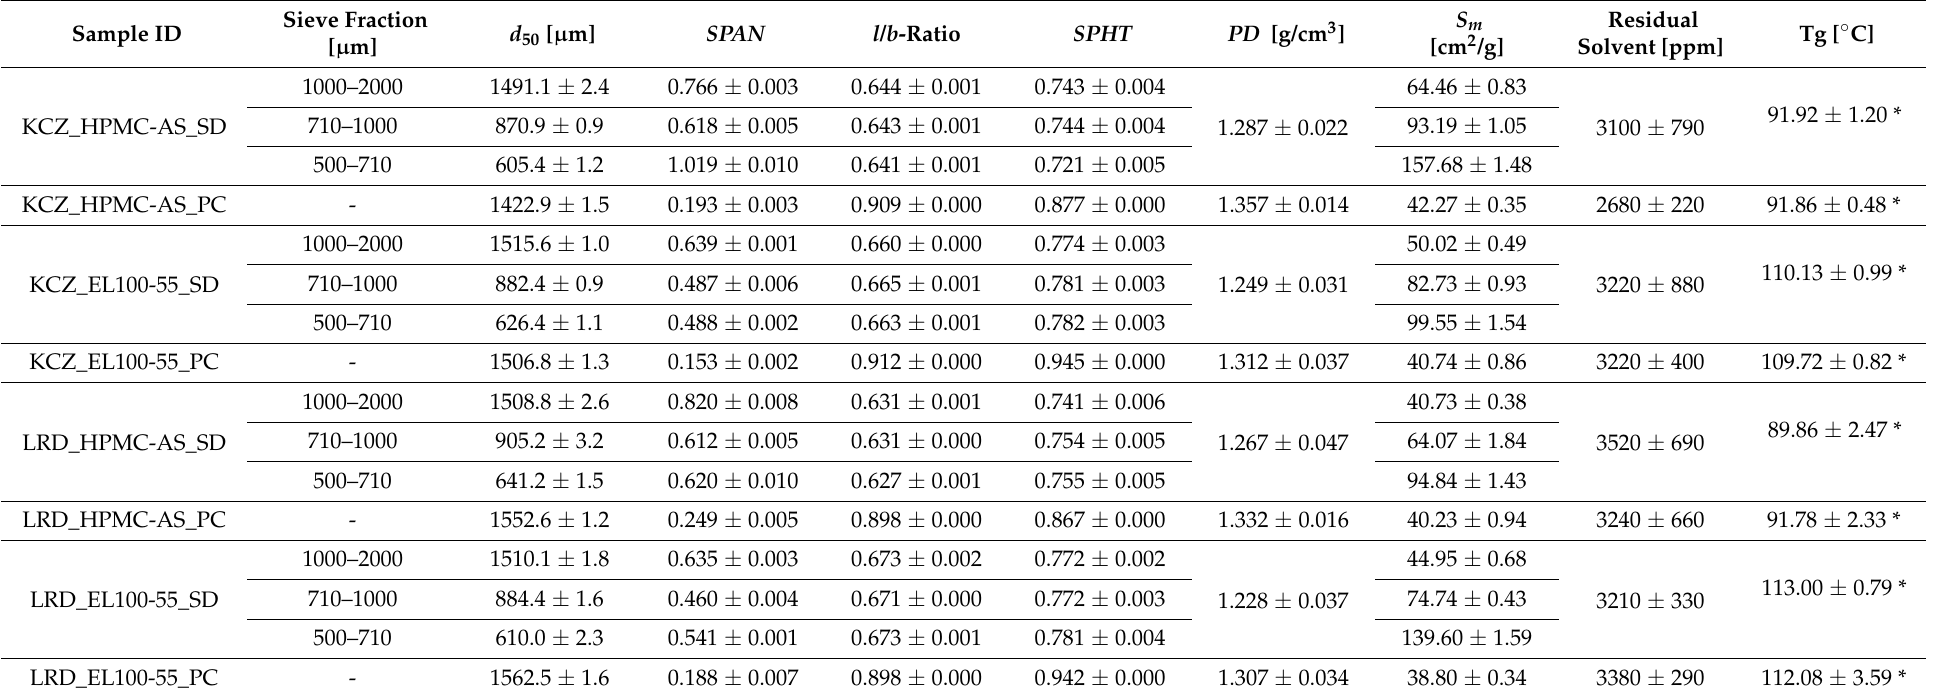
Table 4. Results with standard deviation of the particle analysis, density measurement, GC and